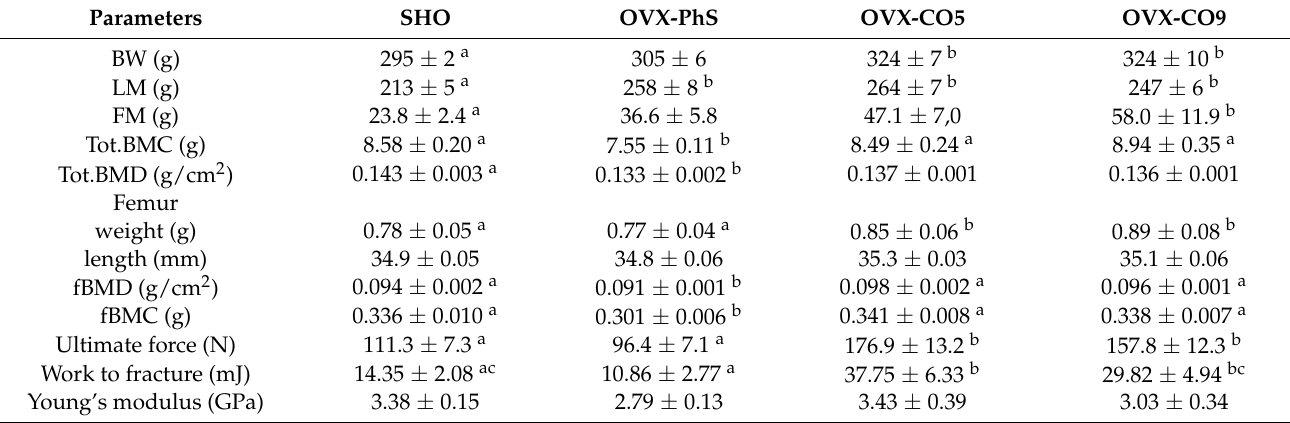
Table 2. Final body weight, parameters of body composition, and densitometric and mechanical properties of femur. Parameters